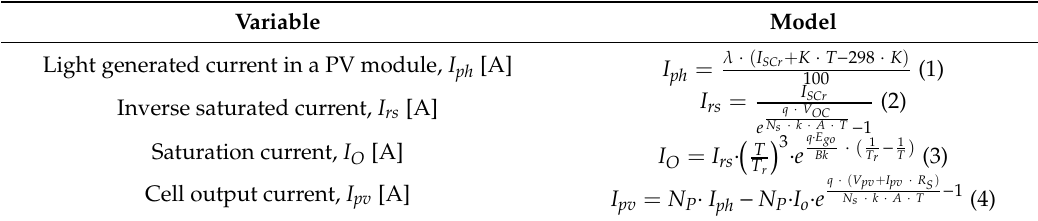
Table 1. Photovoltaic panel